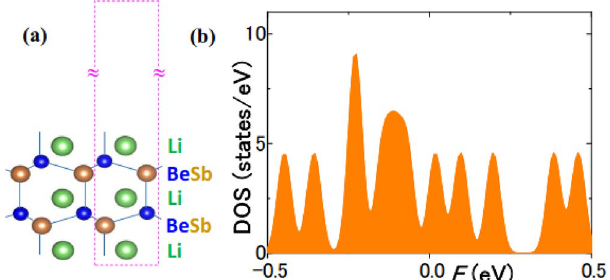
Figure 6. ( a ) Atomic model of LiBeSb/vacuum. ( b ) DOS showing metallicity of